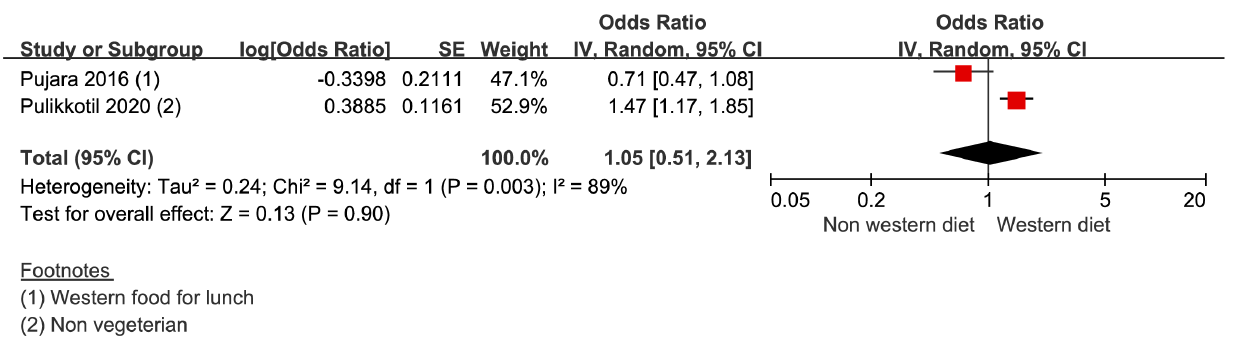
Figure 3. Risk of periodontal disease with dairy products [26–29]. -red color: weight for overall effect ;-black color: 95% confidence interval